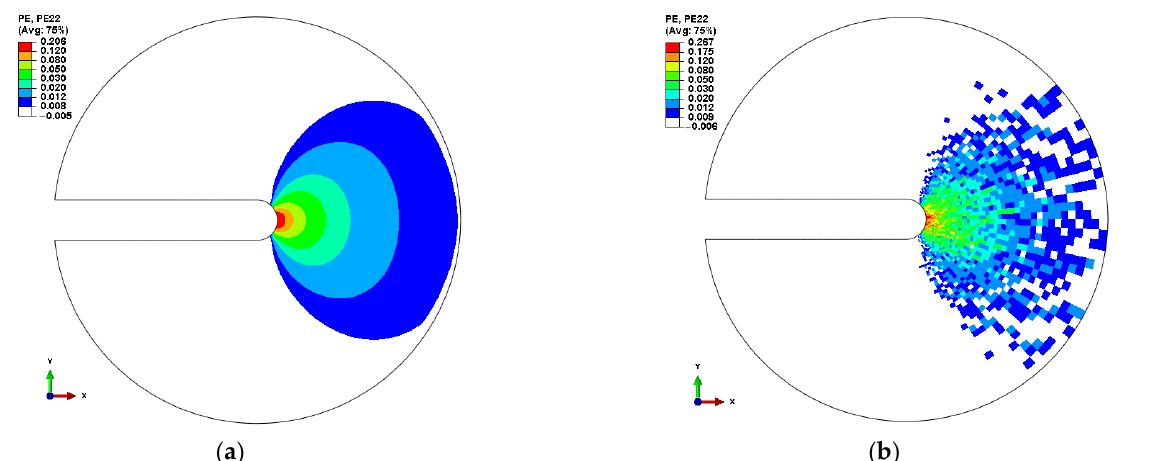
Figure 6. Normal plastic strain (PE22) ahead of the crack tip: ( a ) homogeneous material and ( b ) heterogeneous material.